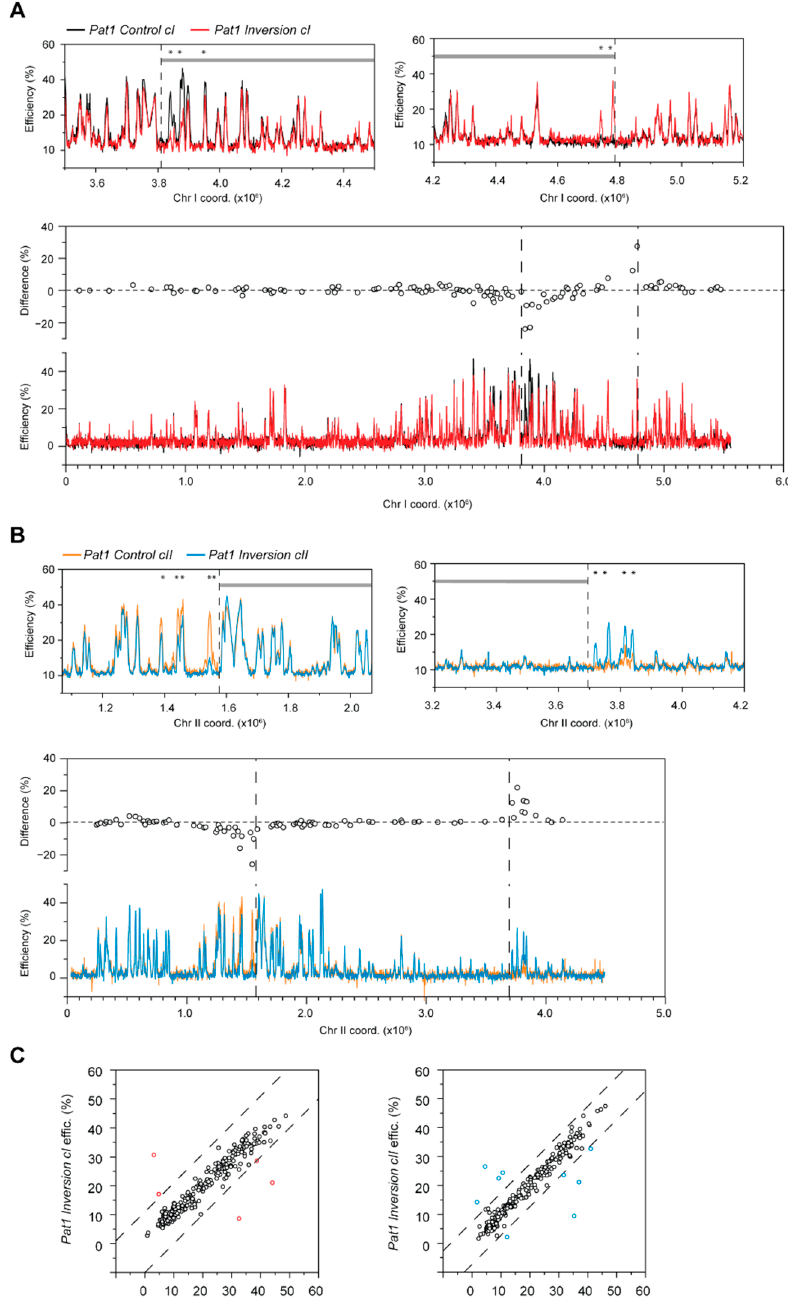
Figure 6. The impact of chromosomal inversions on the efficiencies of individual origins in pre-meiotic S phase. ( A , B ) Differences in replication initiation between inversion and control strains in pre-meiotic S phase. To allow direct comparison with the Pat1 Control strains, the profiles of Pat1 Inversion cI and Pat1 Inversion cII are plotted using the original, pre-translocation coordinates. Only chromosomes harboring the inversions are shown. Dashed lines indicate rearrangement endpoints. x -axis: chromosome coordinates; y -axis: origin efficiencies. Top panels: Detailed view of the replication profiles surrounding the inversion endpoints. Changes in origin usage in Pat1 Inversion cI occur within the inverted fragment, whereas changes in Pat1 Inversion cII are located outside of the inversion. Black: Pat1 Control cI , red: Pat1 Inversion cI , orange: Pat1 Control cII , blue: Pat1 Inversion cII . Asterisks highlight origins that show significant efficiency differences between the Inversion and Control backgrounds . Gray lines delineate the rearranged fragment. Bottom panels: Position-effect of the impact of chromosomal context on origin firing in pre-meiotic S phase. Differences in origin efficiencies between Pat1 Inversion and Pat1 Control strains (circles, top part of each graph).